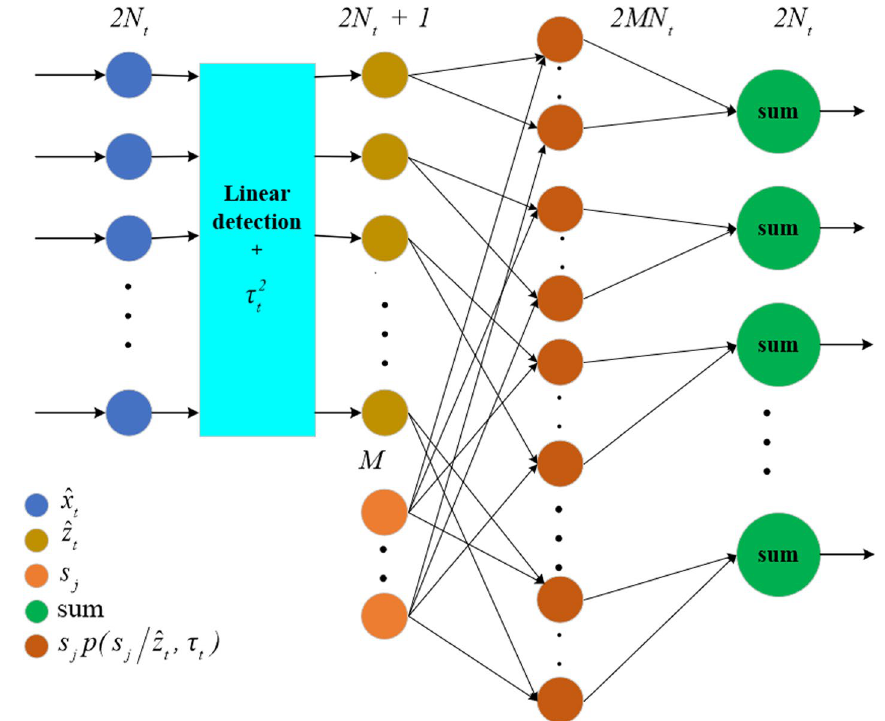
Fig. 7 Deep learning network neuron structure of